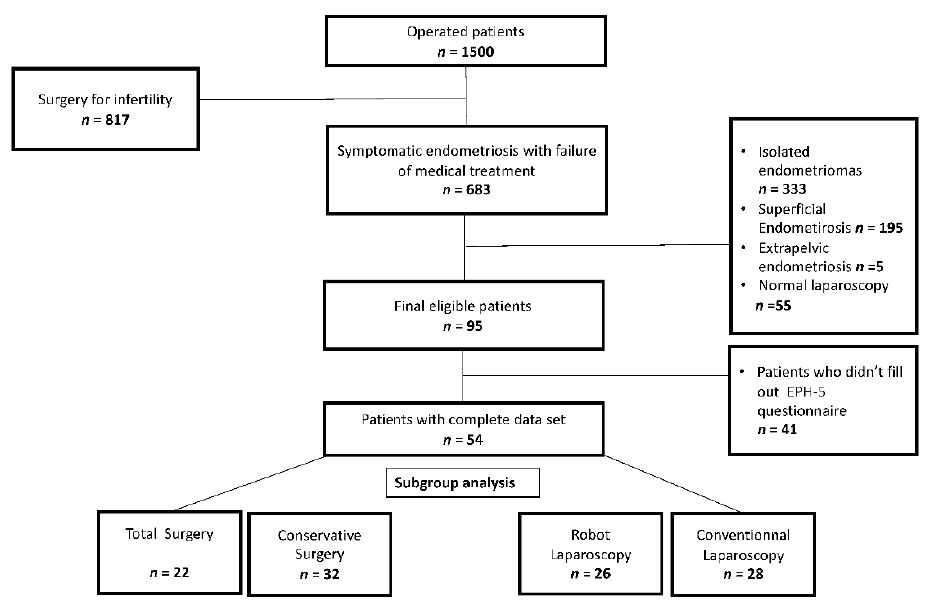
Figure 2. Flowchart of the study.